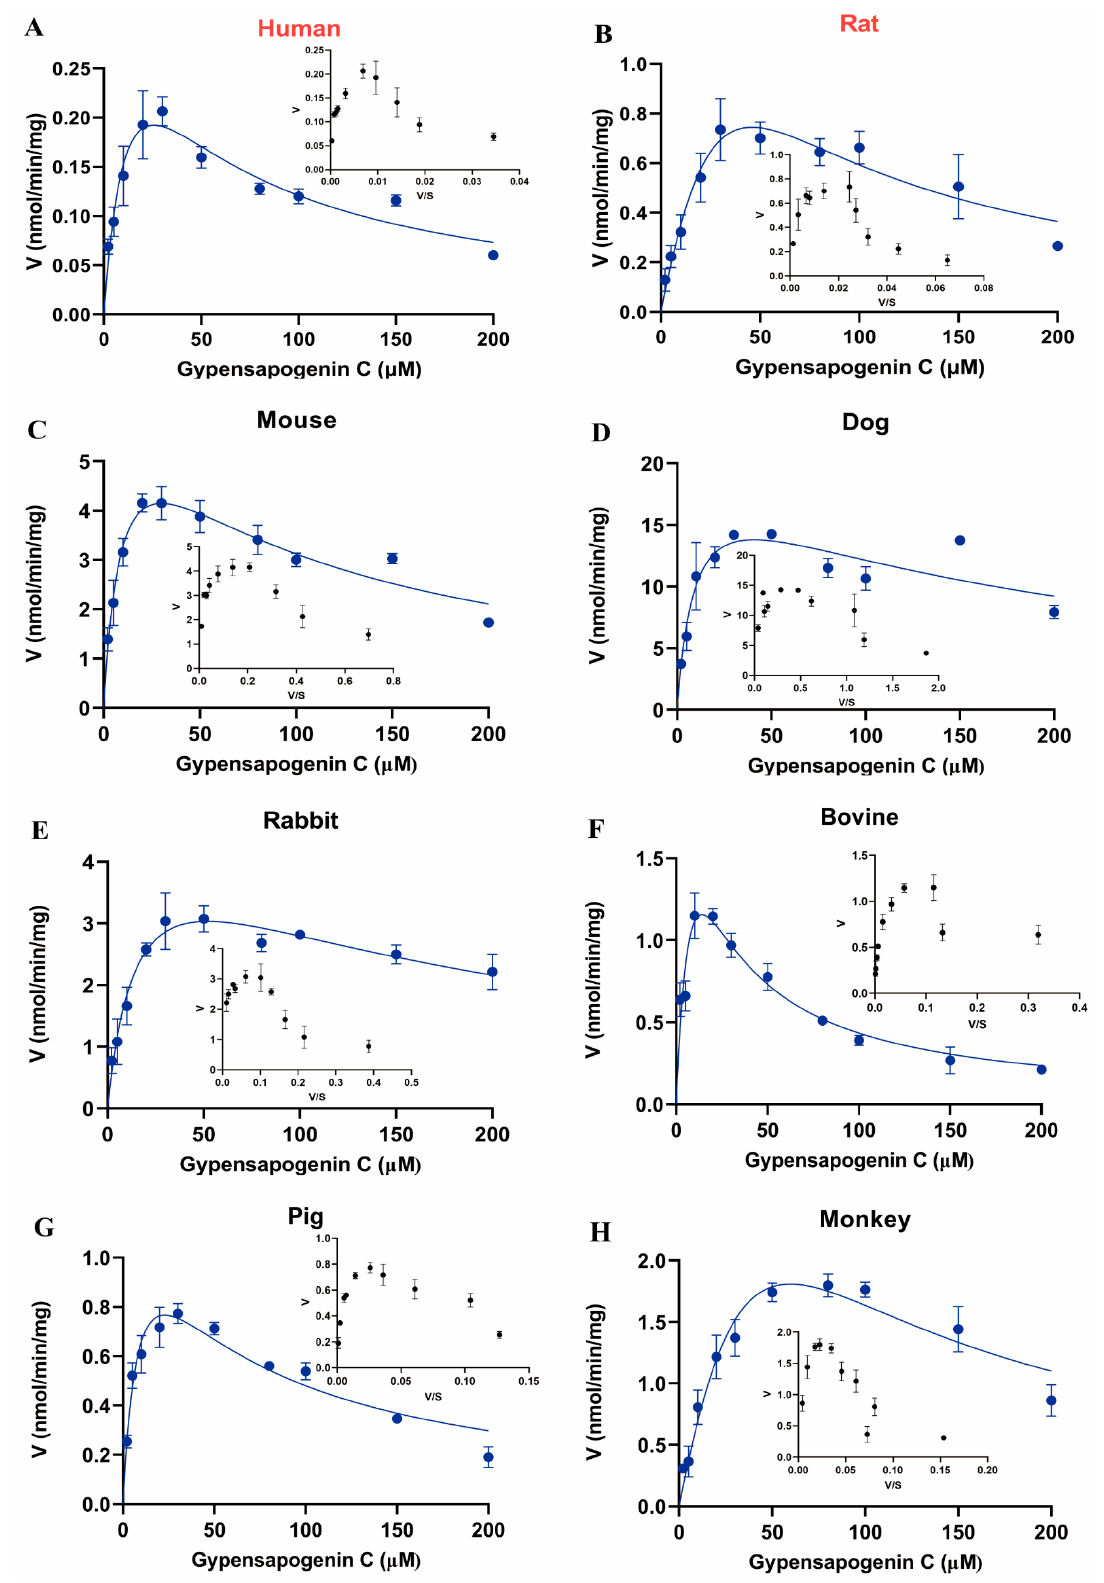
Figure 8. Enzymatic kinetic profiles of GPC metabolism by glucuronidation in liver microsomes